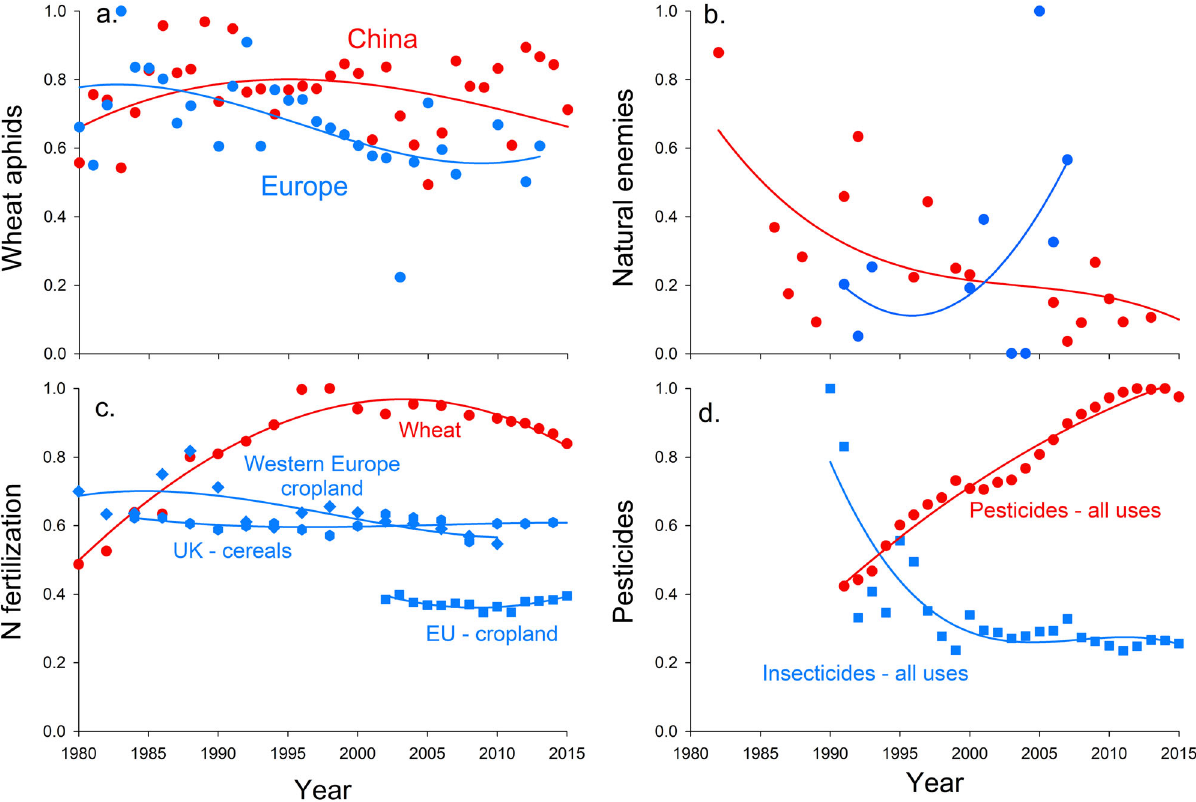
Fig. 3 Wheat aphids, natural enemies and agricultural practices in China and Europe. Trends of wheat aphid loads ( a ), natural enemies ( b ), nitrogen fertilizer inputs per area ( c ), and insecticide or pesticide inputs ( d ) in China and Europe from 1980 to 2015. All values are normalized so that the highest value is set at 1. Normalized values (value of 1) are: aphids = 10^4.49 100 tillers − 1 (i.e., log[aphids] = 4.49 is set to 1); natural enemy loads = 63.5 100 tillers − 1 ; N fertilization = 289 kg ha − 1 yr − 1 ; pesticide use [China] = 1.8MT yr − 1 , insecticide use [Europe] = 5kT AI country − 1 yr − 1 . Curves are third order polynomials fi t to illustrate general patterns and not for statistical